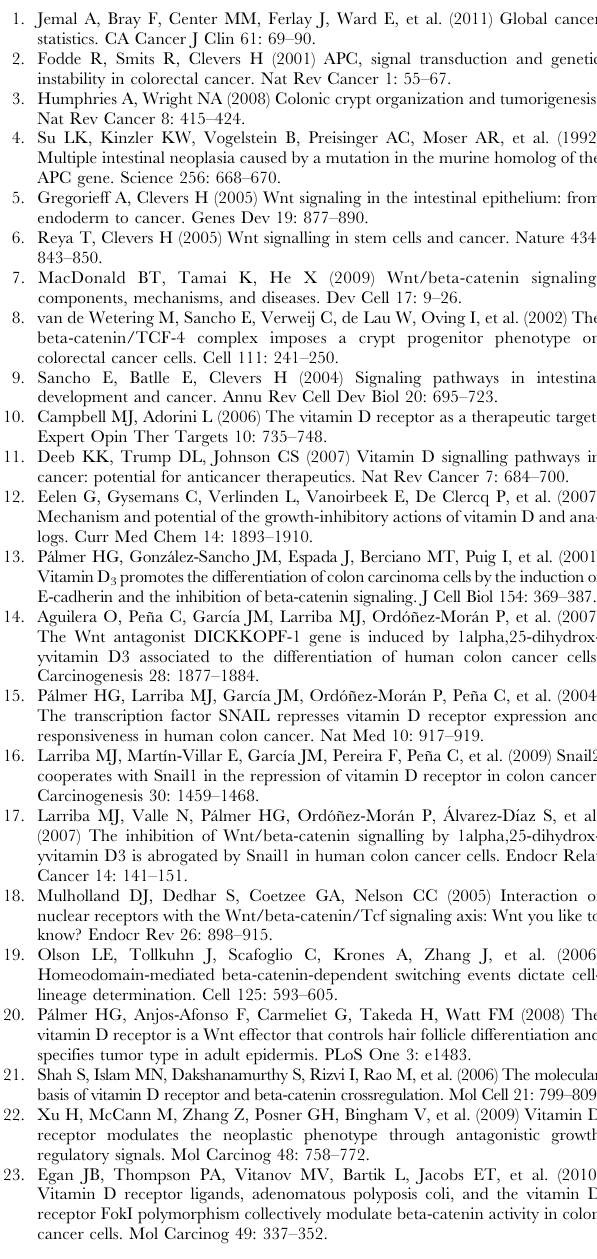
Figure S5 Pan-cytokeratin and villin1 are differentia- tion markers in mouse colon tissue. Representative immunofluorescence images showing b -catenin and pan-cytoker- atin (a) or b -catenin and villin1 (b) staining of mouse normal colon tissue. Both pan-cytokeratin and villin1 markers stain the differentiated cells located at the upper part of the normal mouse colon crypts. Scale bar, 50 m